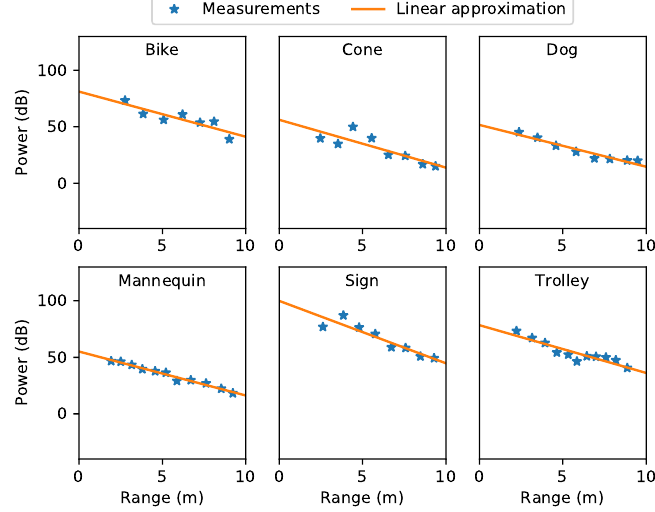
Figure 4. Received power as a function of range for all